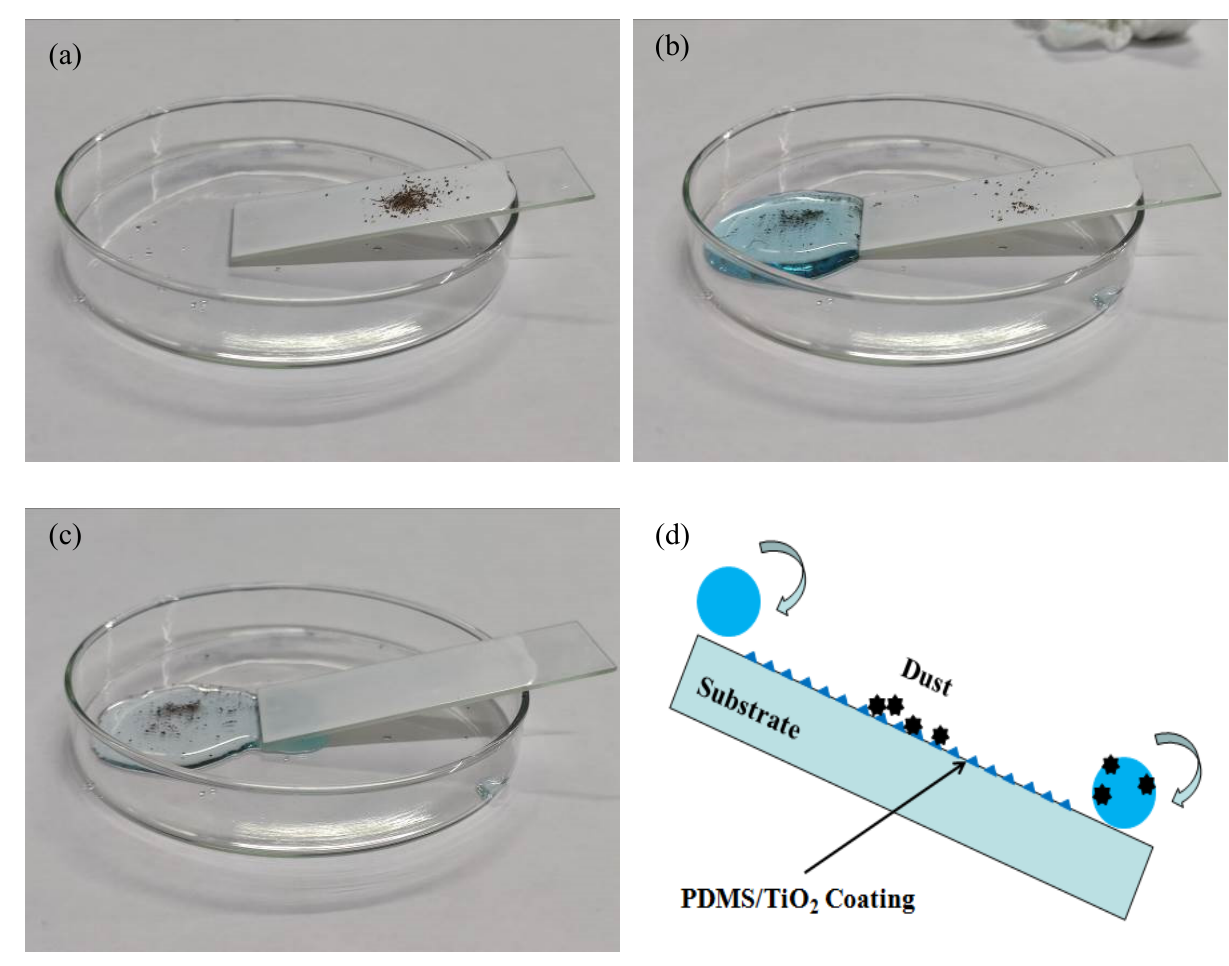
Figure 8. Self-cleaning properties of the PDMS/TiO 2 coating: ( a ) before ( b ) during and ( c ) after water droplet cleaning; ( d ) Schematic illustration of the self-cleaning process.